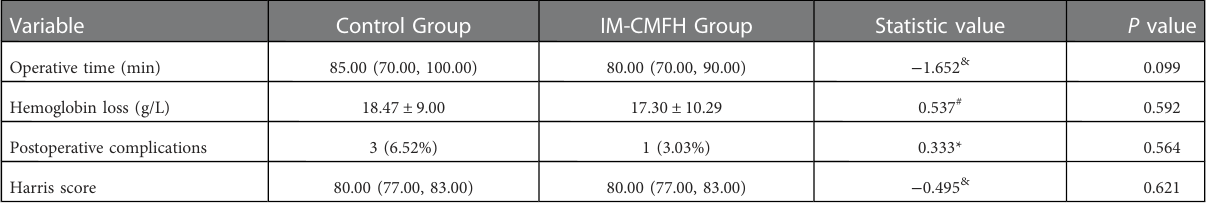
TABLE 4 Comparison of the operative time, hemoglobin loss, postoperative complications, and harris score.